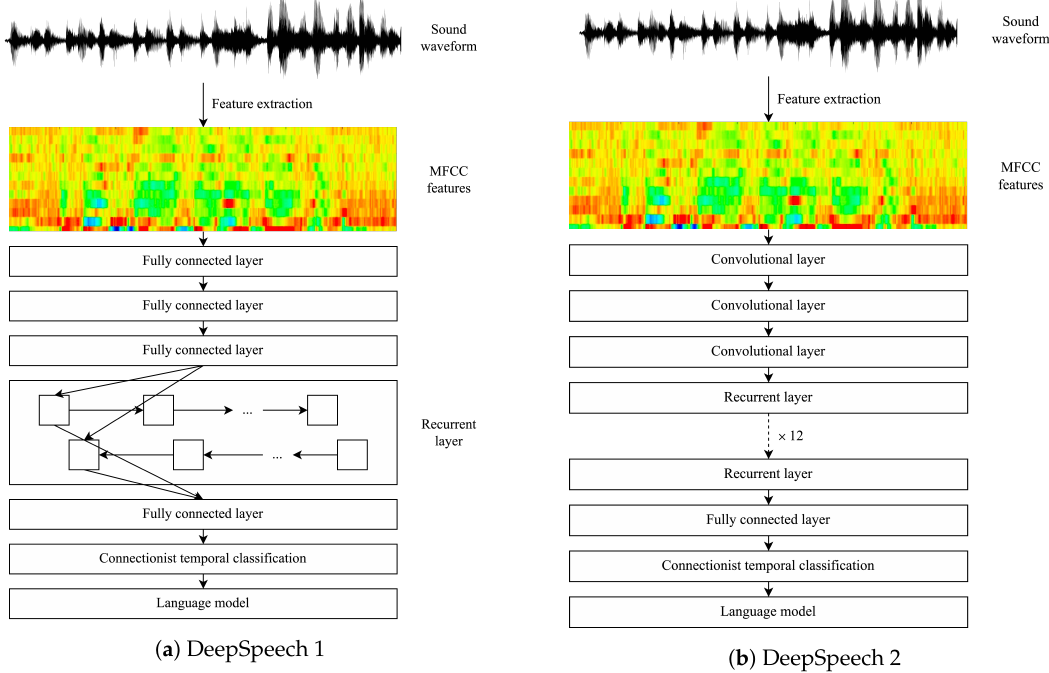
Figure 3. Architecture of DeepSpeech Automatic Speech Recognition